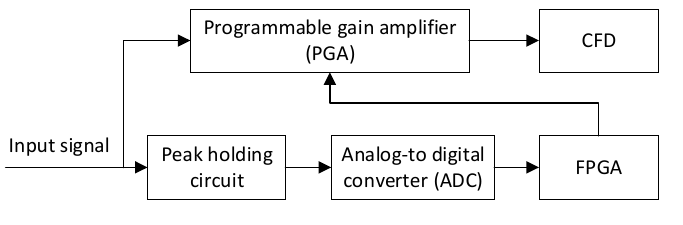
Figure 2. Schematic diagram of AGC.